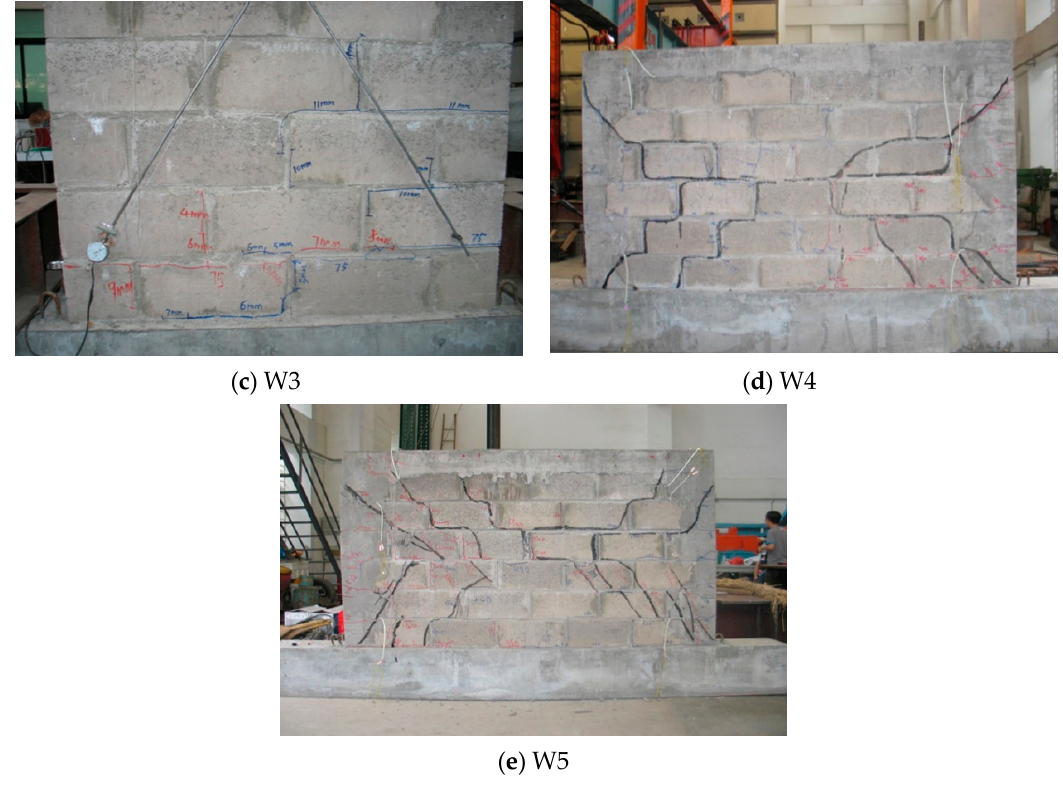
Figure 8. Failure mode of specimens: ( a ) W1; ( b ) W2; ( c ) W3; ( d ) W4; ( e ) W5. Table 4. Characteristic load and